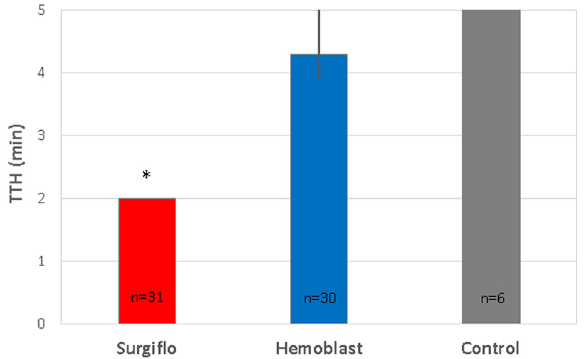
Fig. 3 Time to hemostasis (TTH) in porcine spleen model of bleeding. TTH is expressed as median and 95% con fi dence interval (CI, open